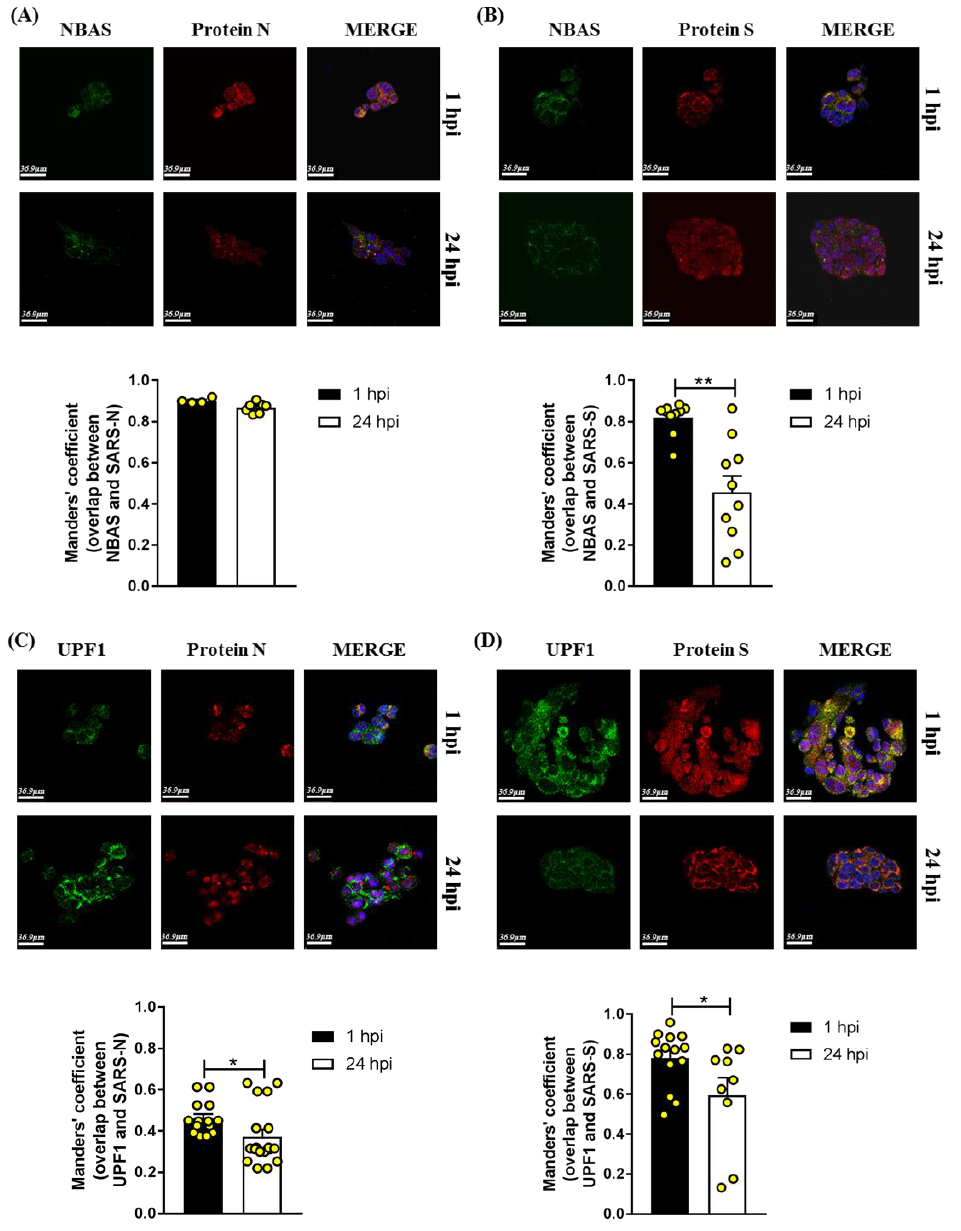
Figure 7. Representative images of immunofluorescence analysis of infected Calu3 cells stained at 1 and 24 h post-infection (hpi) for NBAS, UPF1, and SARS-CoV-2 proteins (N or spike); nuclei are shown in blue (DAPI). Scale bar: 36.9 µm. Manders ’ coefficient was calculated for the quantification of the co-localization of NBAS or UPF1 proteins with protein N (panels ( A , C ), respectively) or with spike protein (panels ( B , D ), respectively) * p < 0.05, ** p < 0.01, Mann – Whitney test.